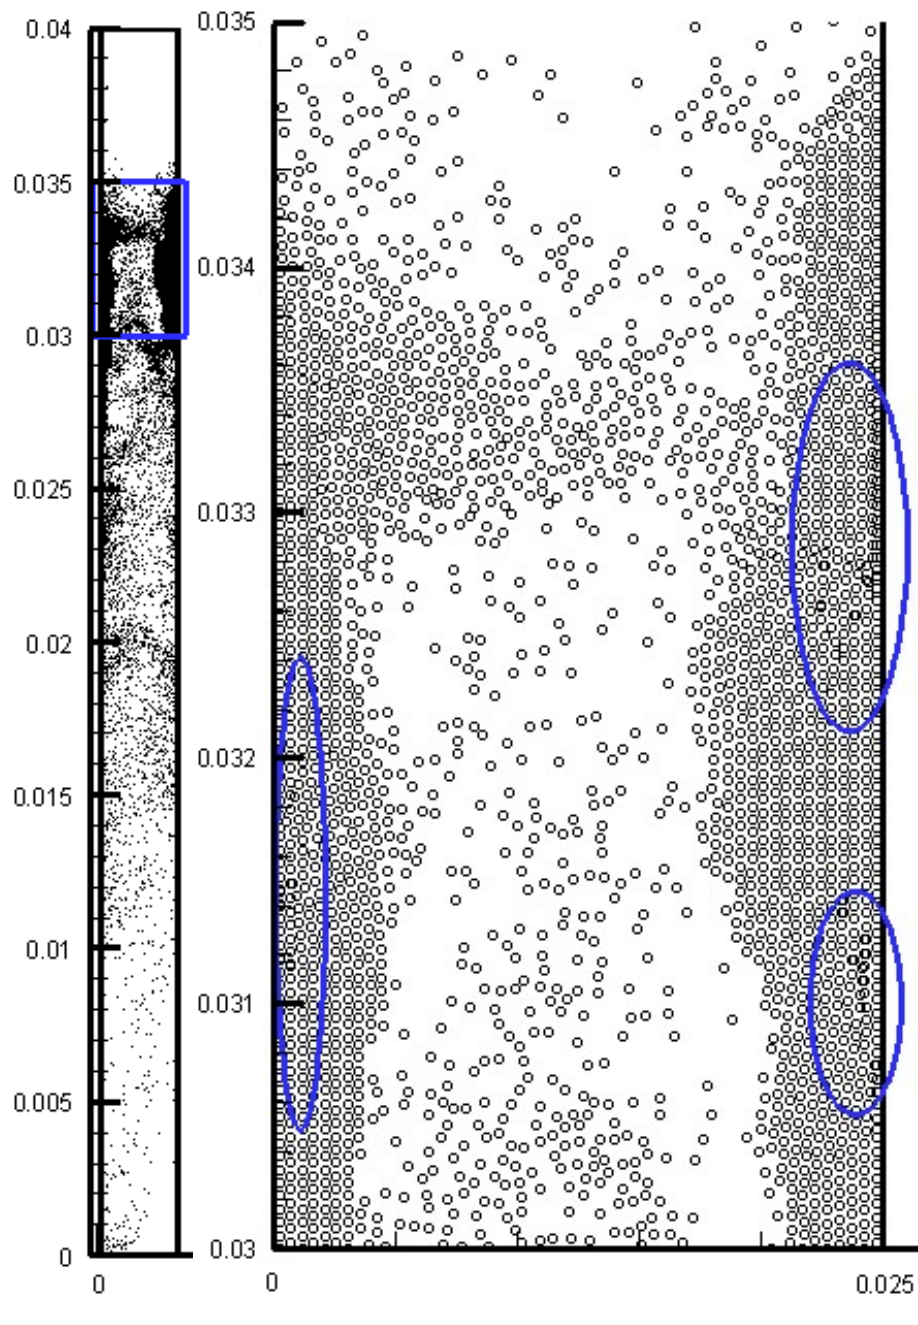
Figure 1. Particle locations at 0.079 s, with over-large 0.45 t r = 0.31 t r